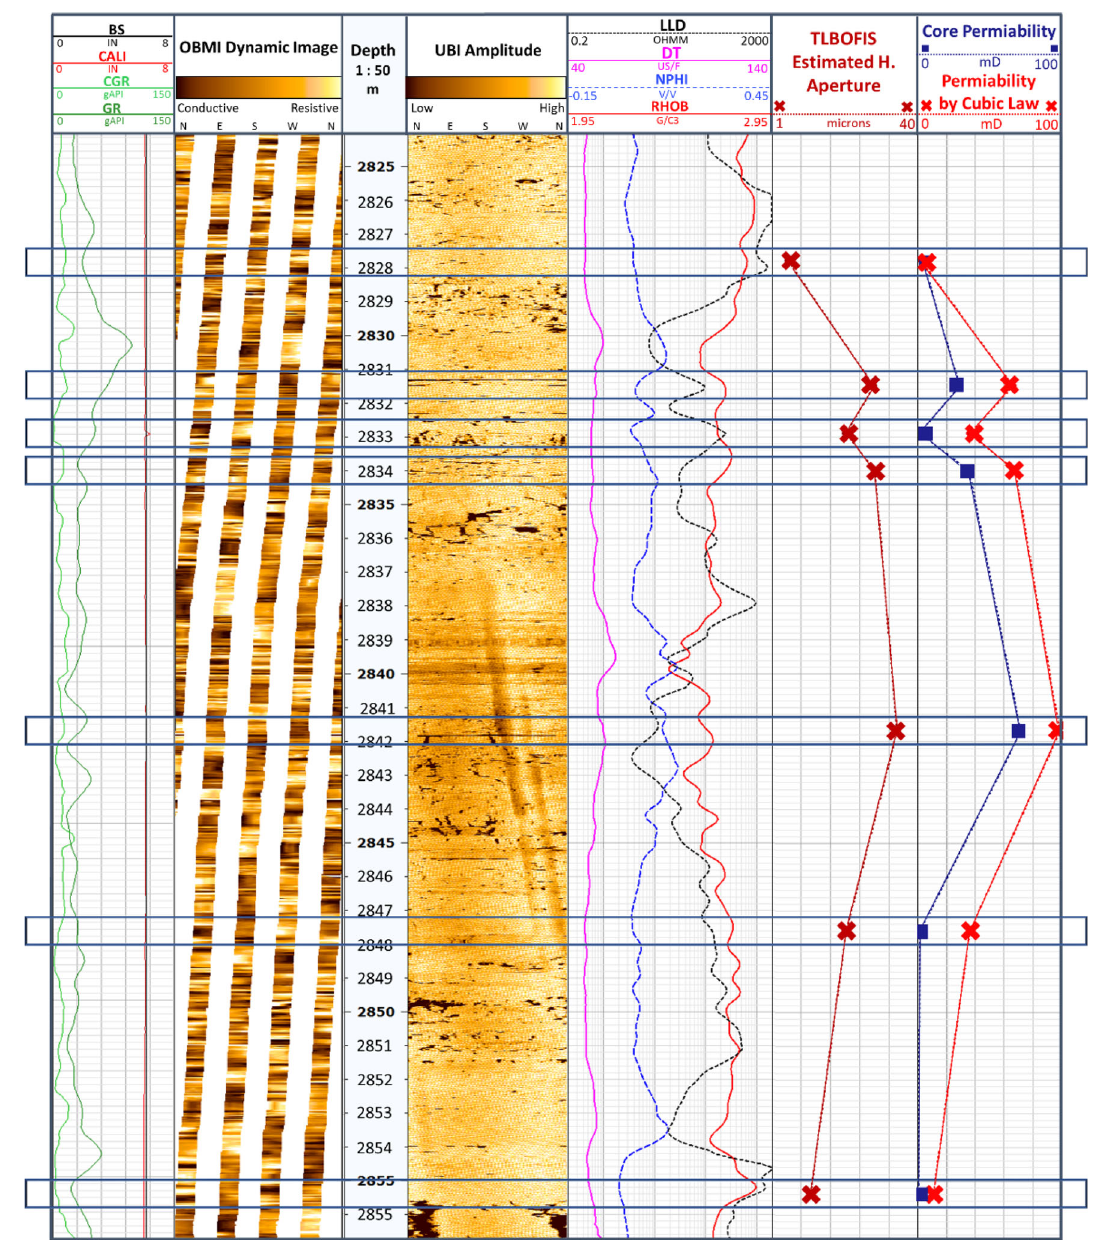
Fig. 10 Processed image logs, conventional well logs, and estimated hydraulic aperture for each fracture plane. The last column shows the comparison between core permeability and derived algorithm-specific parameters and the highest accuracy of